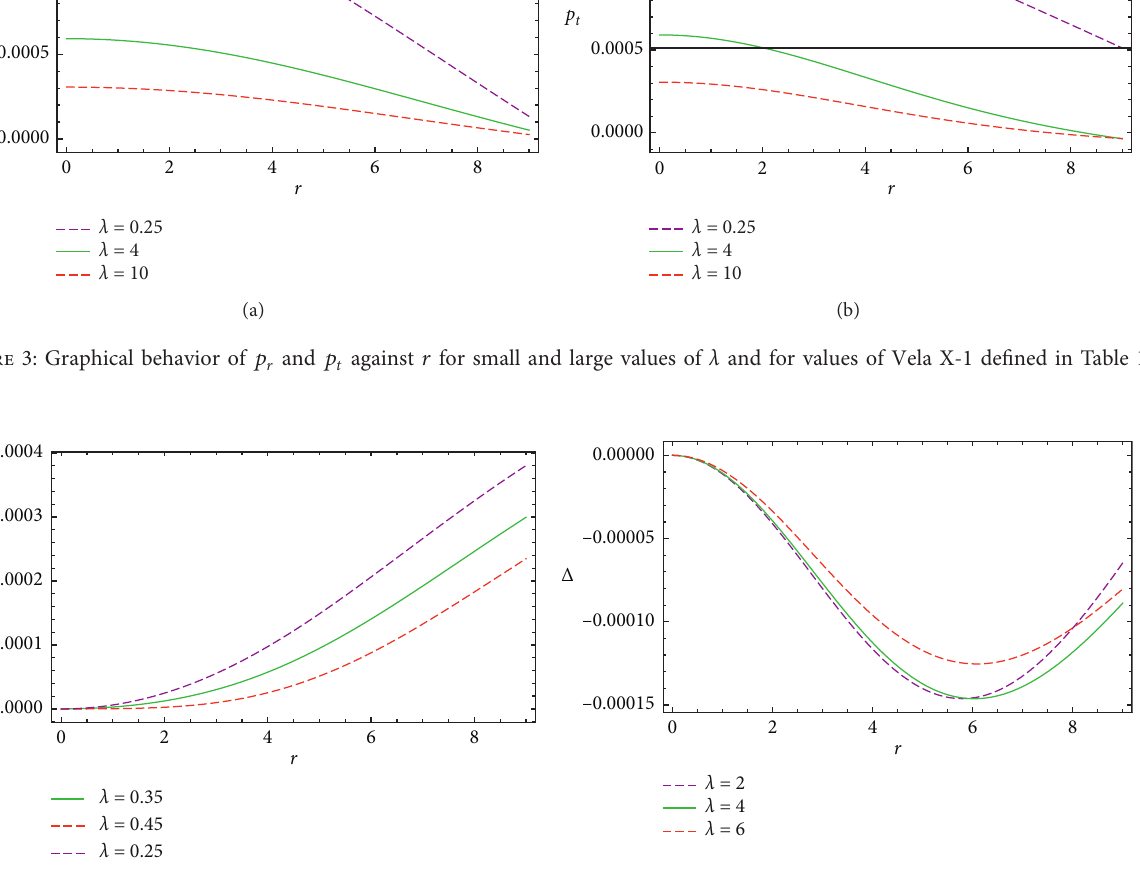
Figure 4: Left panel shows the graphical behavior of Δ against r for three small values: λ � 0 . 25 , 0 . 35 , 0 . 45 while right panel provides the behavior for three large values: λ � 2 , 4 , 6 for known values of Vela X-1 defined in Table 1.